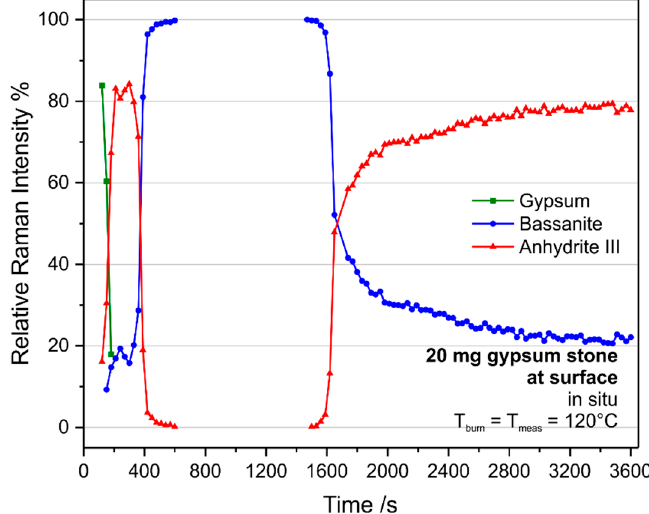
Figure 10. Change of relative intensities of the ν 1 bands of gypsum, bassanite, and anhydrite III during heating of a 20-mg gypsum stone to 120 °C. The measurements were carried out at the surface.